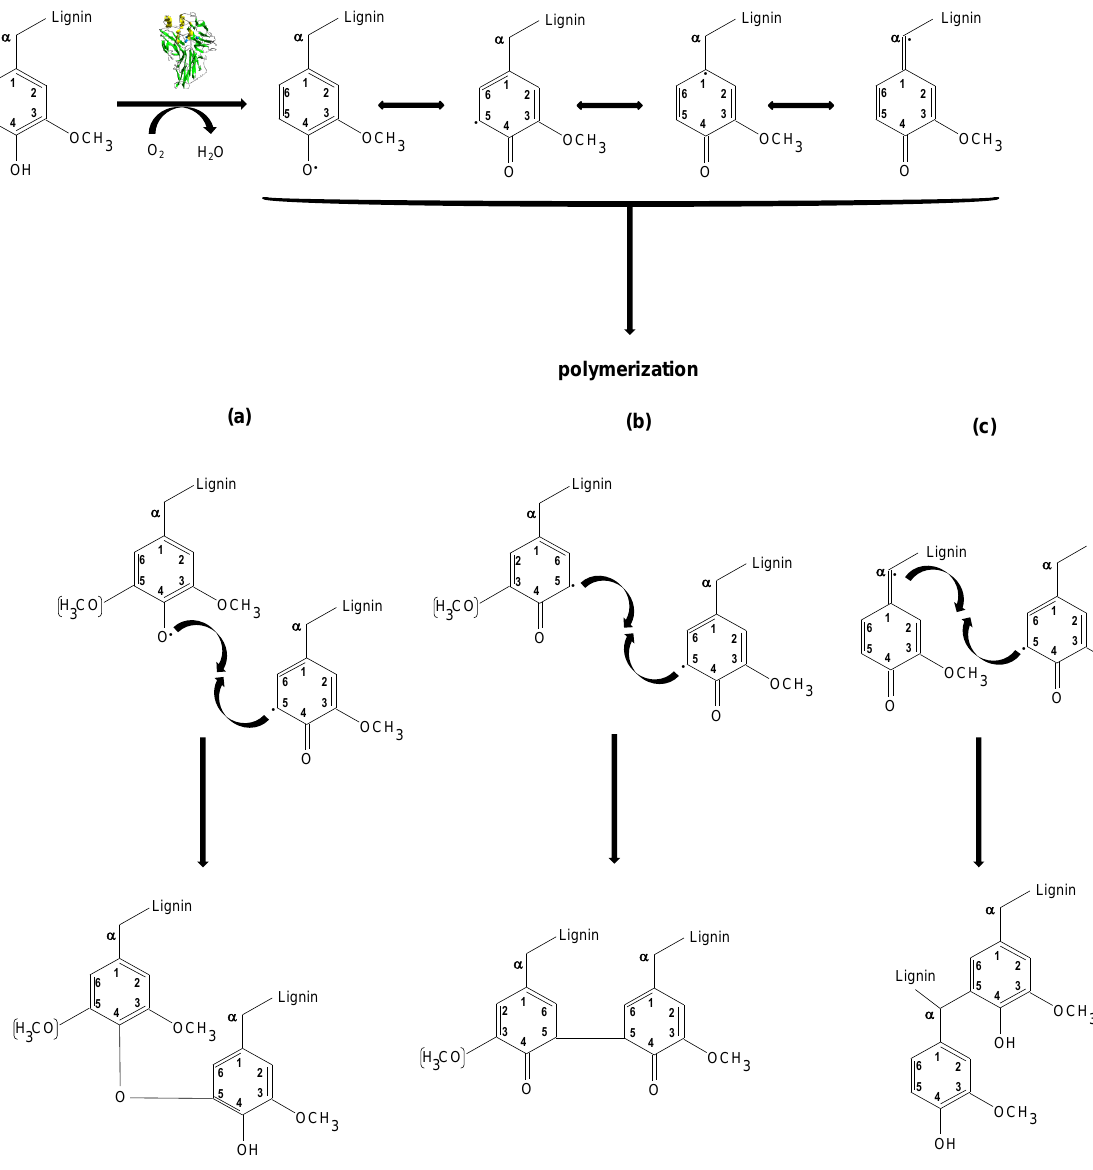
Figure 9. Schematic representation of oxidative lignin polymerization catalyzed by laccase. Radical coupling leads to formation of new condensed structures such as 4-O-5 ’ ( a ) 5-5 ’ ( b ), and α -5 ’ ( c ).